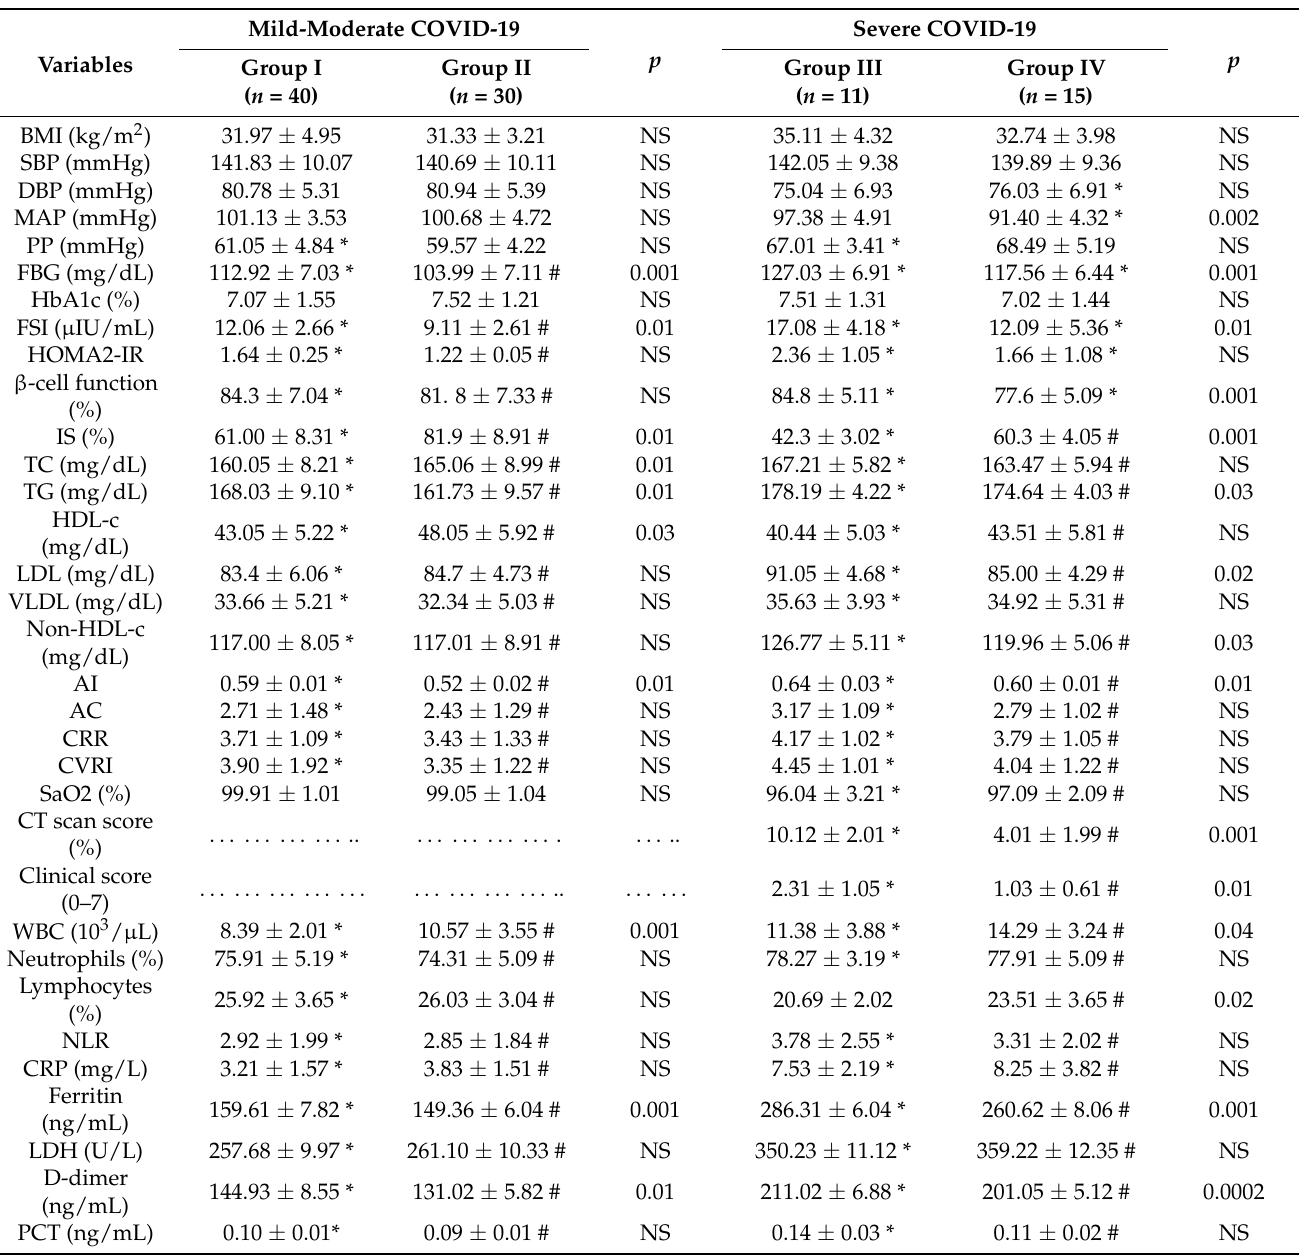
Table 5. Metformin effects versus metformin plus sitagliptin on anthropometric and biochemical variables in T2DM patients with